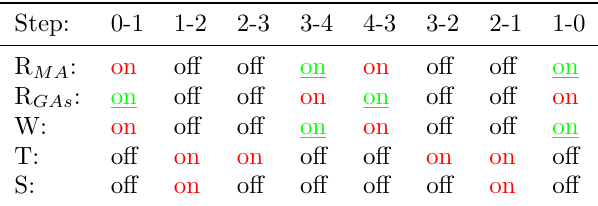
Table 7: Actuation